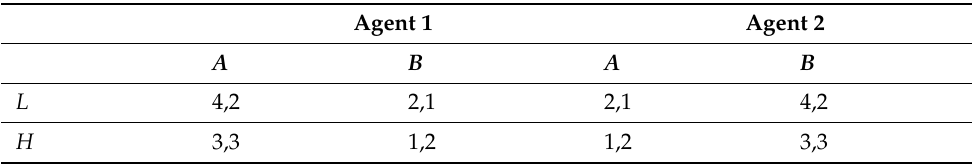
Table 1. Static incentive contracts with two